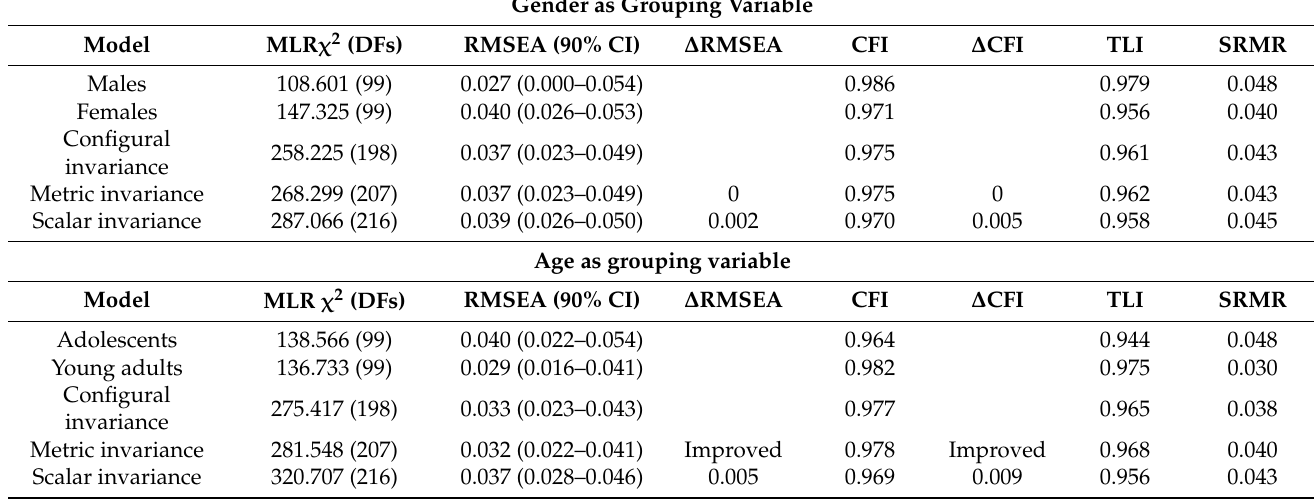
Table 4. Factorial invariance tests of the CERQ-IS across gender and age. Different scaling correction factors are related to χ 2 statistics since robust maximum likelihood estimation method (MLR) was